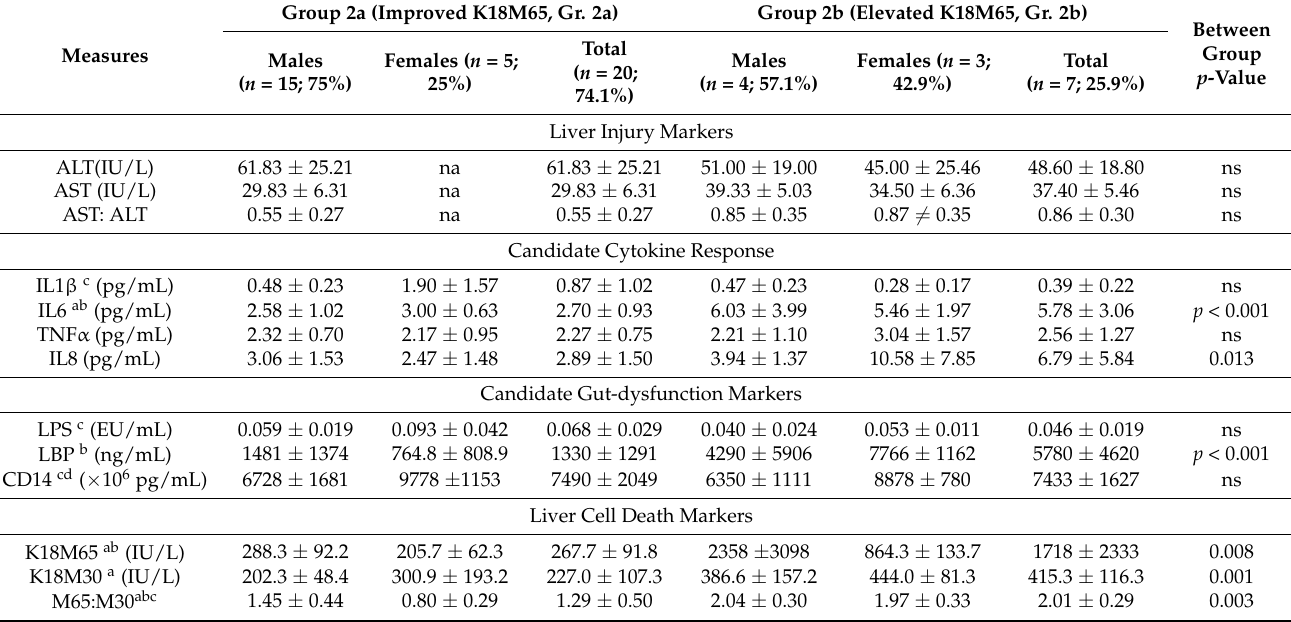
Table 3. Liver injury measures, nutritional status, candidate blood panel measures, cytokines, gut dysfunction markers, and cell death markers of the alcohol use disorder patients after 2 weeks of SOC comparing patients with improved K18M65 < 500 IU/L (Gr.2a) and patients with elevated